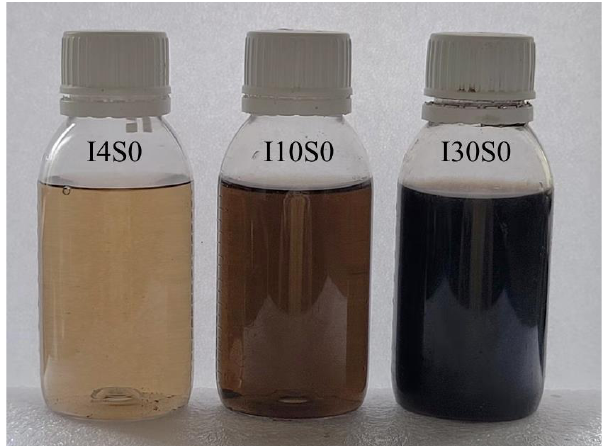
Figure 11. Suspensions recycled from tap water electrolyte (diluted by 5 times).